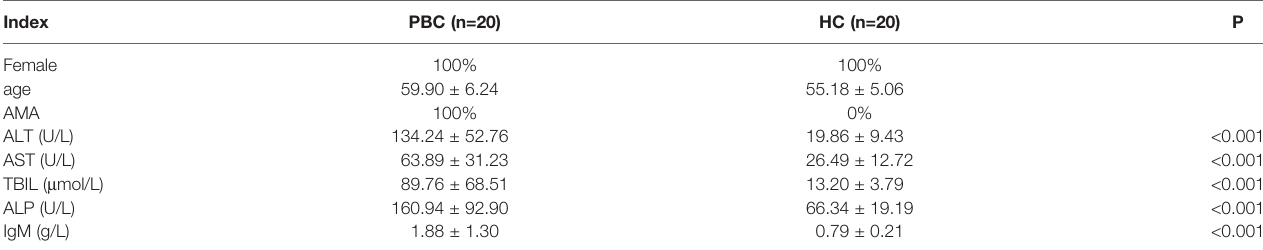
TABLE 2 | The relevant clinical indicators of PBC patients and